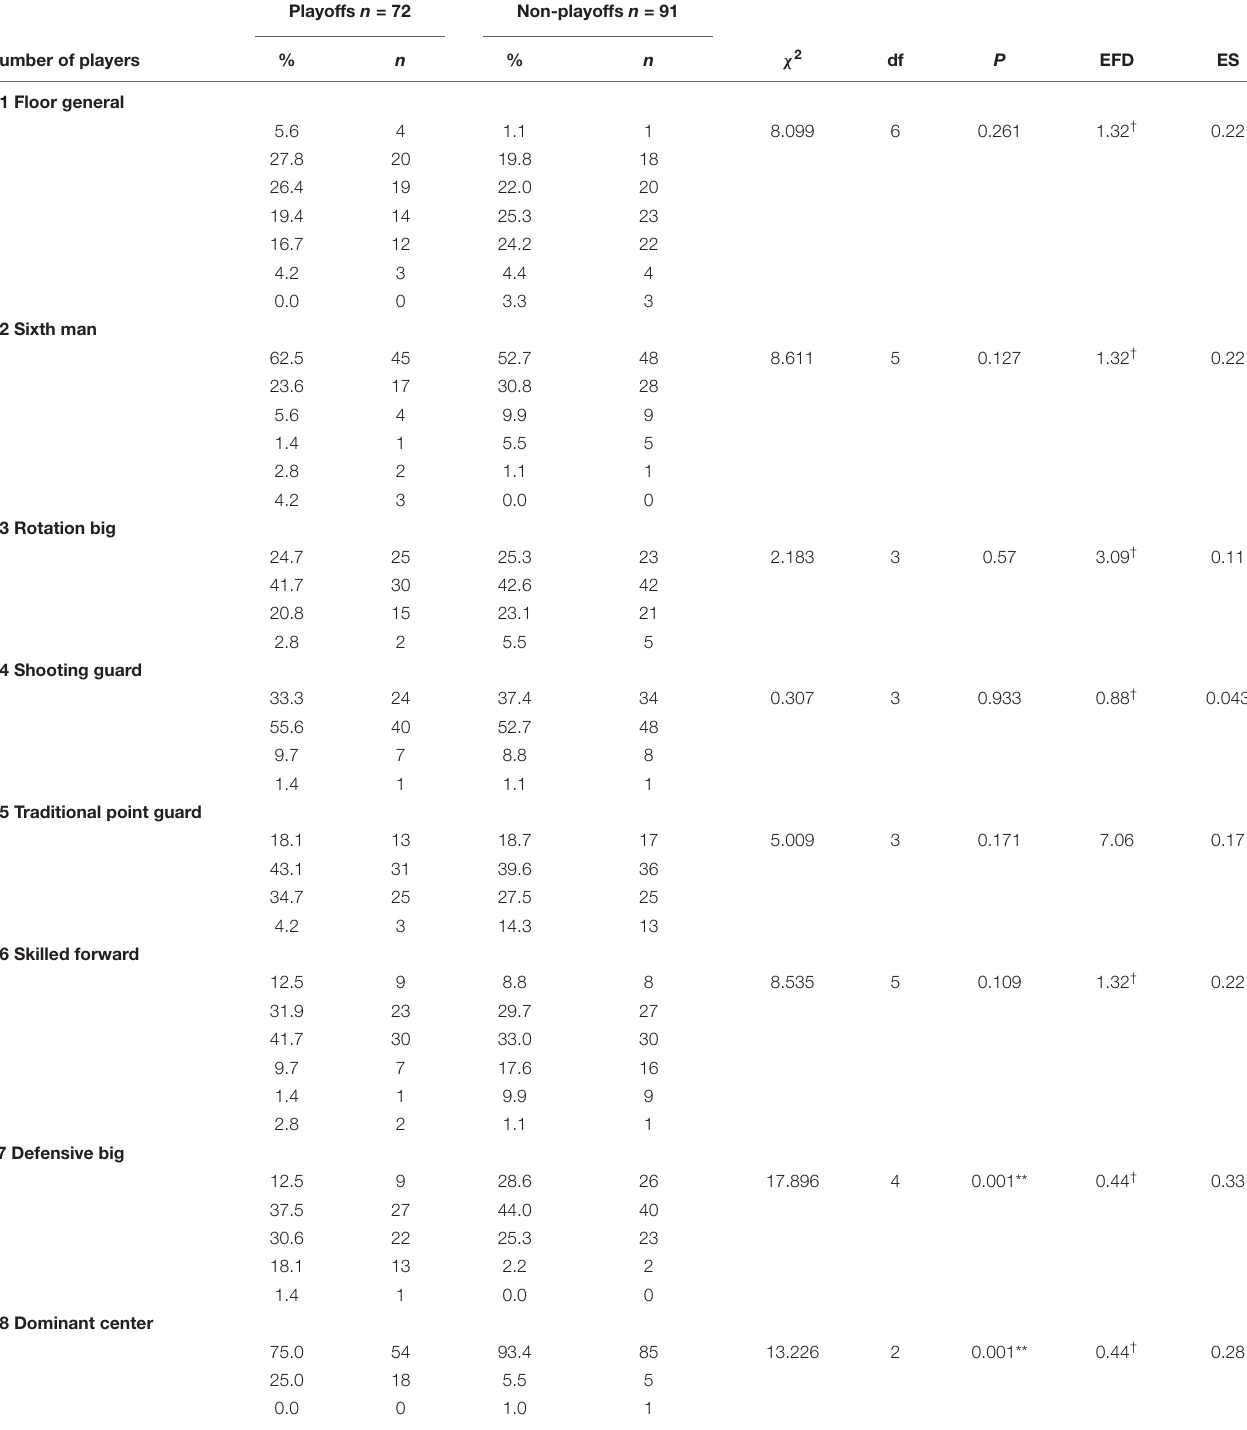
TABLE 2 | Frequency distribution (%) of team ability according to the number of native player clusters (crosstab command: Pearson’s Chi-square, degrees of freedom, significance, expected frequency distribution, and effect size). Playoffs n = 72 Non-playoffs n =